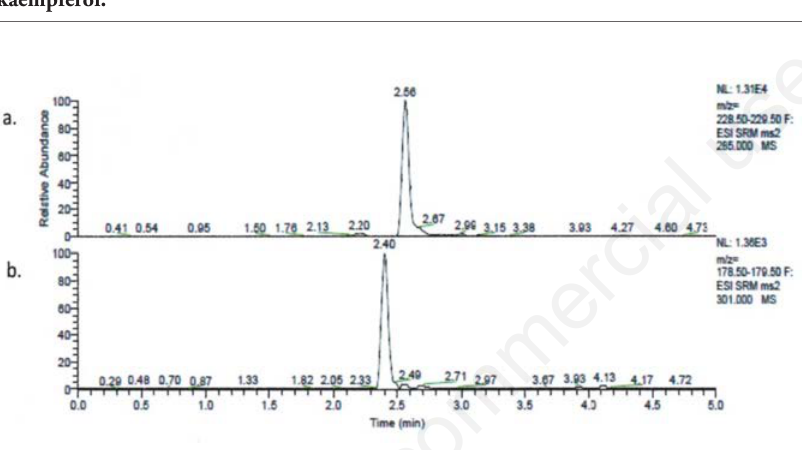
Figure 5. HPLC results for M. malabathricum L. flower bloom (M) (a) quercetin, (b) kaempferol.